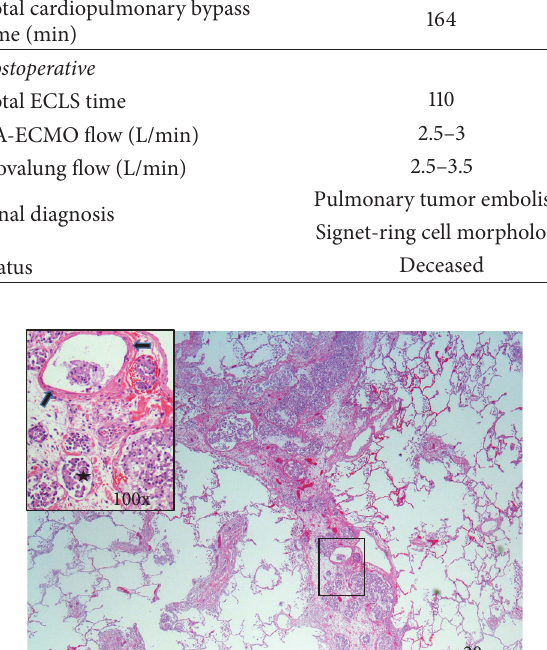
Figure 3: Section of lung showing diffusely thrombosed artery with recanalization and small focus of intra-arterial malignant cells (arrow).Insetalsoshowsadjacentlymphaticchannelwithmalignant cells (star). Green arrow points to the muscular wall of the artery. Hematoxylin and eosin.